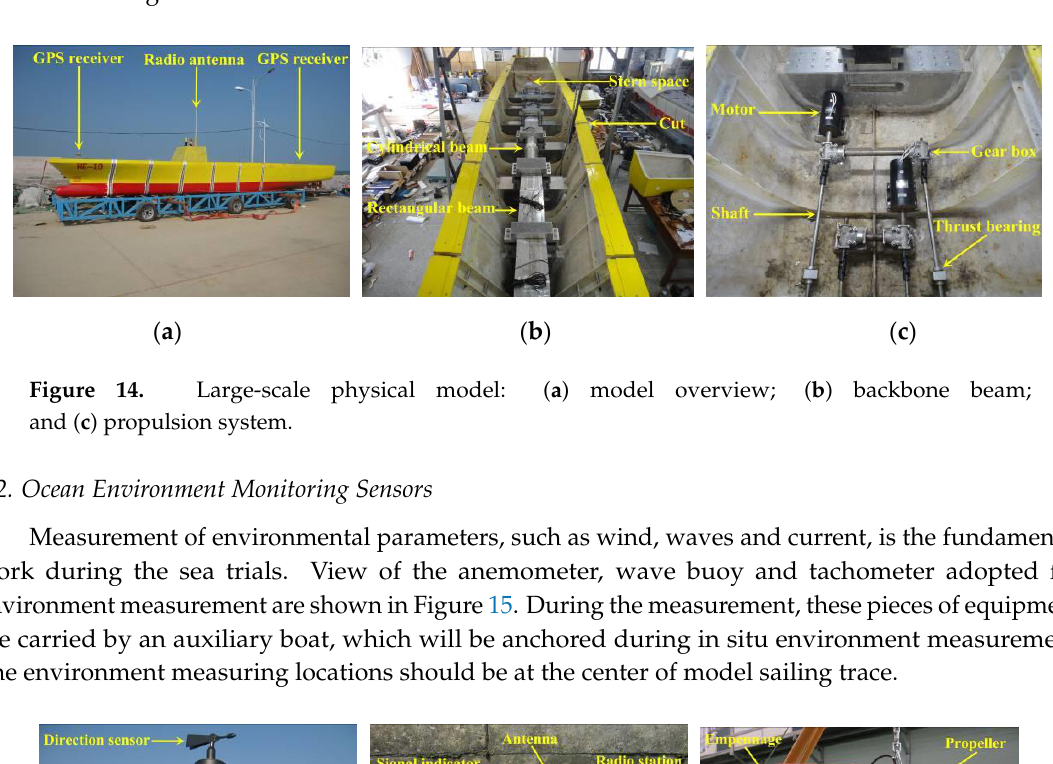
Figure 13. Sensors arrangement on the large-scale model.